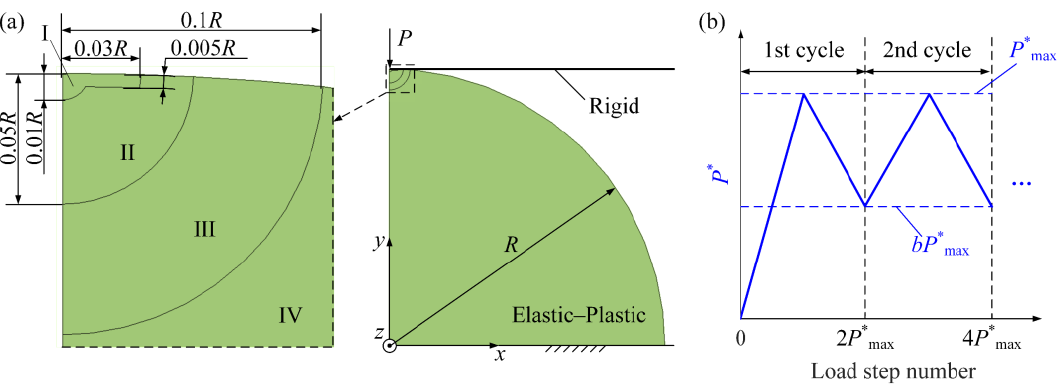
Figure 2. ( a ) Details of the finite element FE model and ( b ) the normal contact loading history.